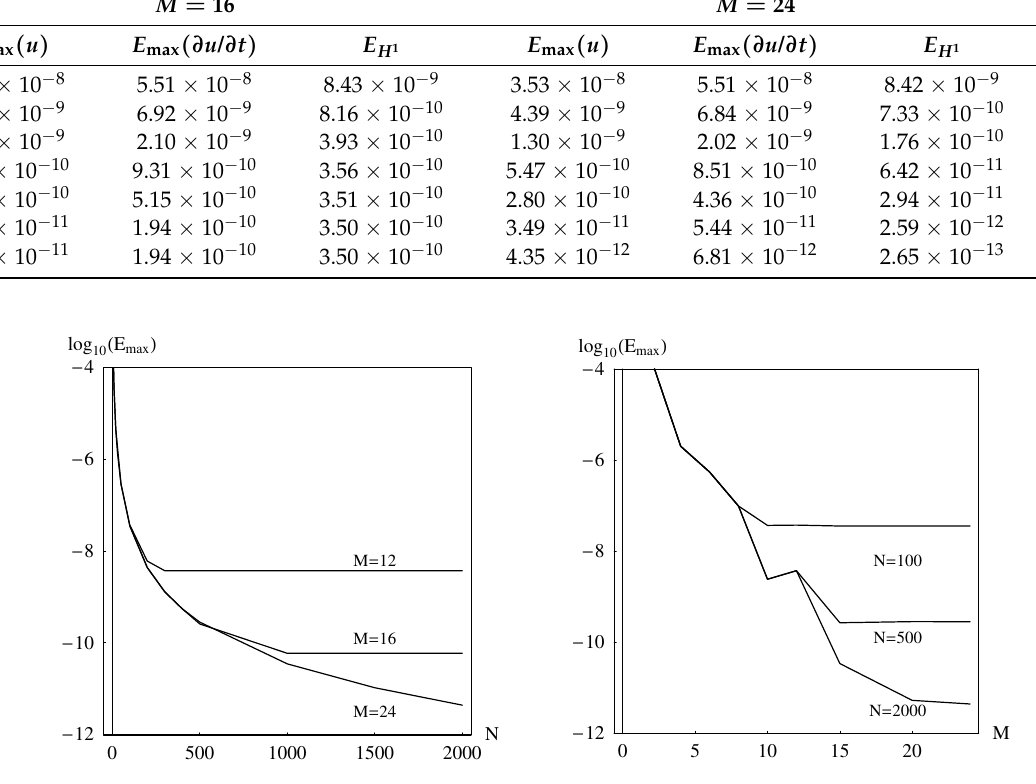
Figure 2. The MAE with respect to the parameters M and N